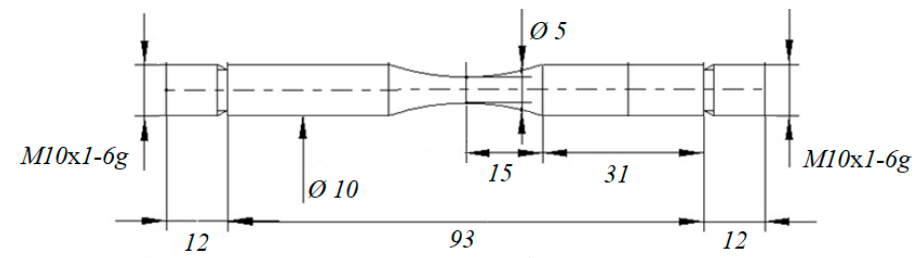
Figure 2. The specimen geometry used for dynamic preloading and cycle tests (sizes in mm).